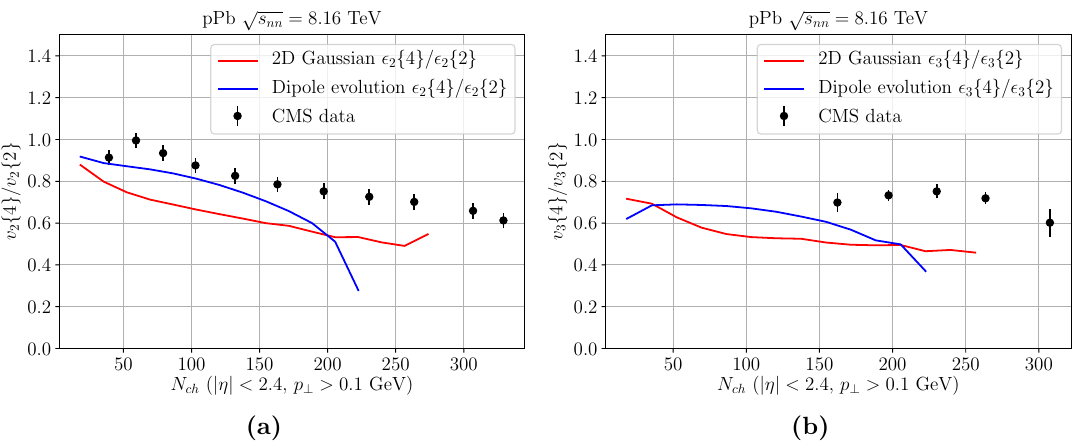
Figure 14. Ratios of v n of multiplicity in pPb collisions, compared to eccentricity ratios calculated with the Gaussian and the dipole